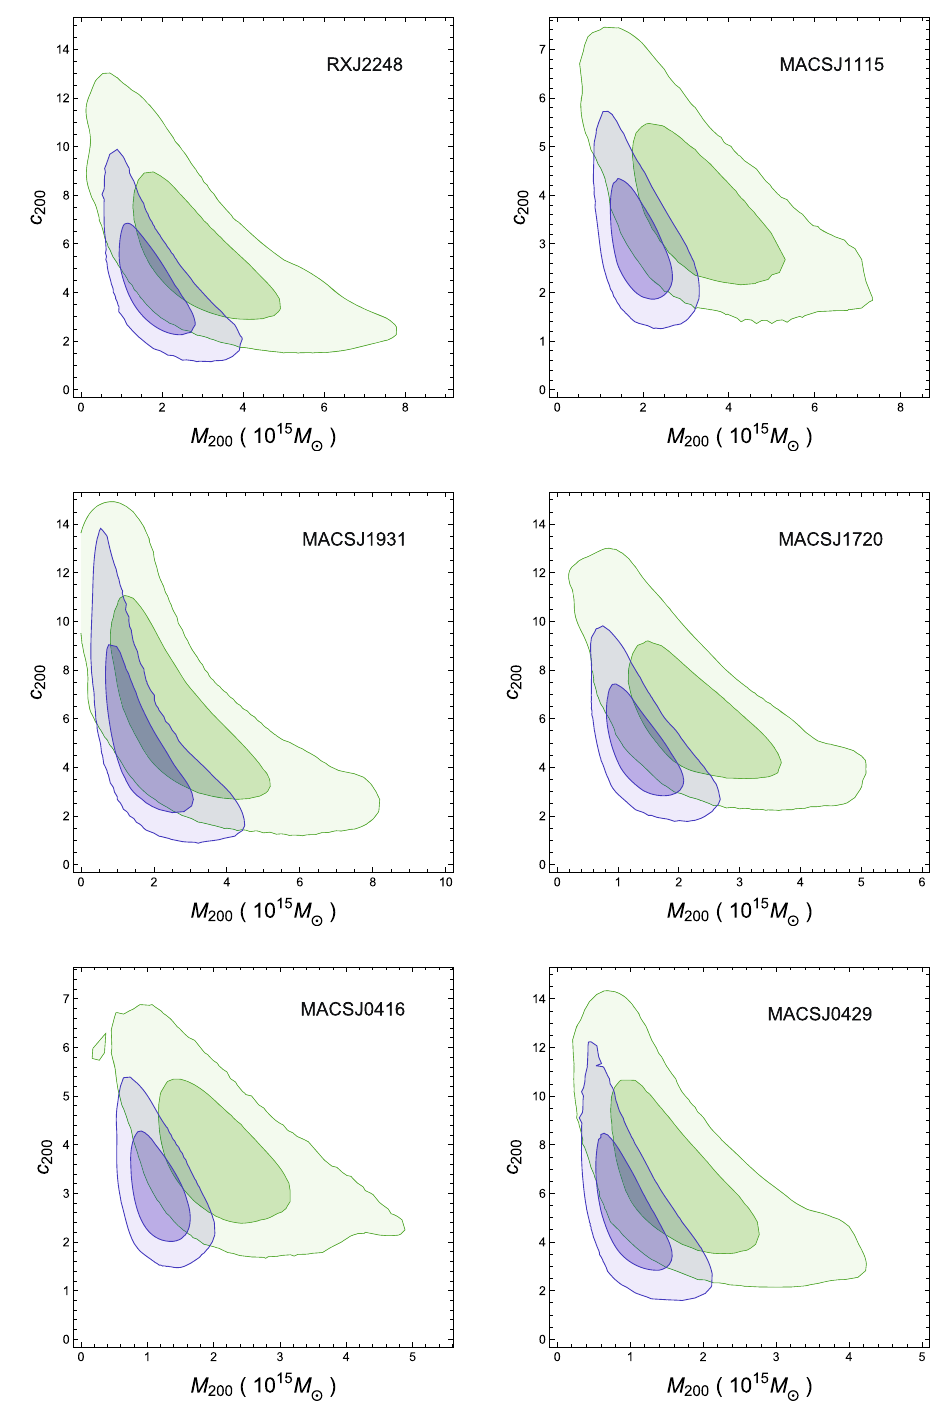
Fig. 4 Contour plot: blue—GR;